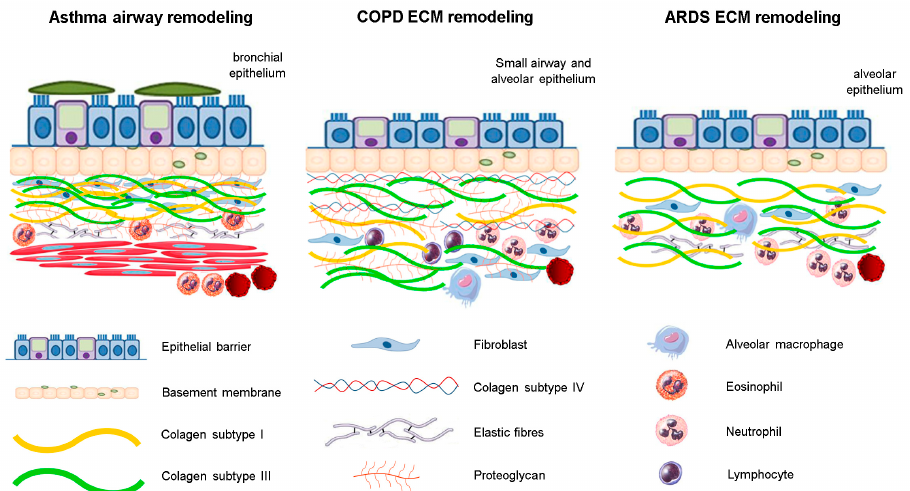
Figure 1. The structural changes of ECM components in respiratory diseases. There is an inflammatory process associated with different fibers rearrangement. In asthma, structural changes are mainly in the bronchial epithelium, whereas in ARDS, these are observed near the alveolar epithelium. In COPD, the ECM remodeling is observed predominantly in small airways and distal areas of parenchyma.